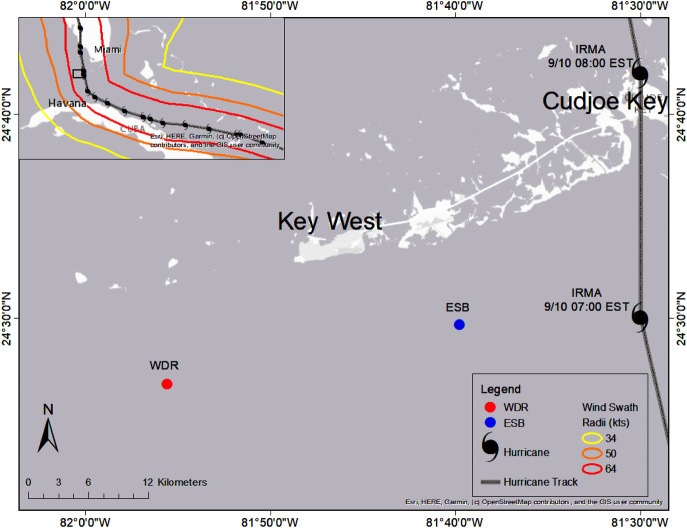
Study site–FKNMS Zone D.Sites are denoted by initials: Western Dry Rocks (WDR) is shown in red and Eastern Sambo (ESB) is shown in blue. NOAA wind swath data are shown as contour lines for maximum sustained wind speeds for 2mins/10meters at 34kts (yellow), 50kts (orange), and 64kts (red). Credit: NOAA NHC Best Track Data updated 06/30/2018.